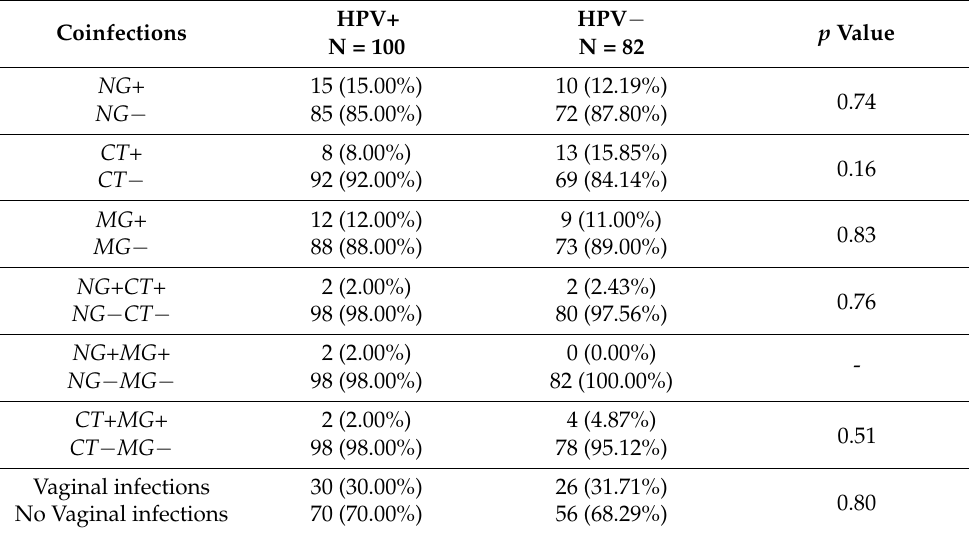
Table 4. Coinfection with HPV, NG , CT , MG and TV among sex professionals in our study. Vaginal infections: cumulative